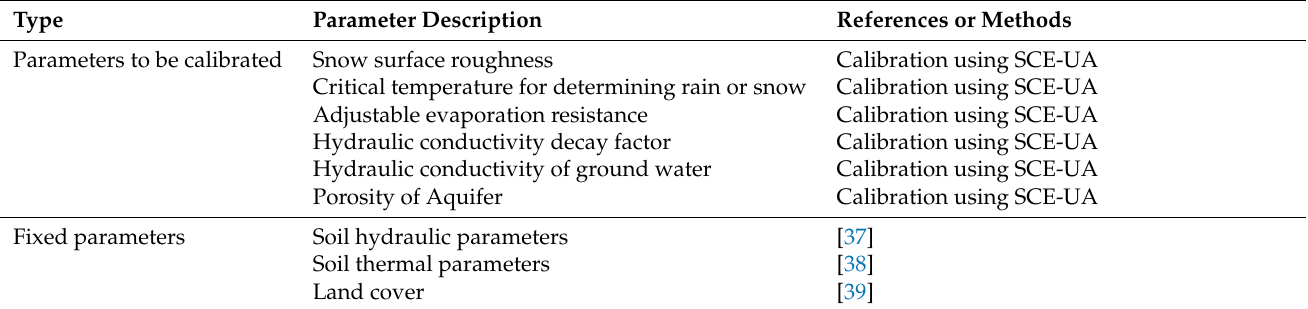
Table 1. Key parameters used in the GBEHM model. The soil hydraulic parameters and the soil thermal parameters are from published datasets. The other six parameters to be calibrated are basin